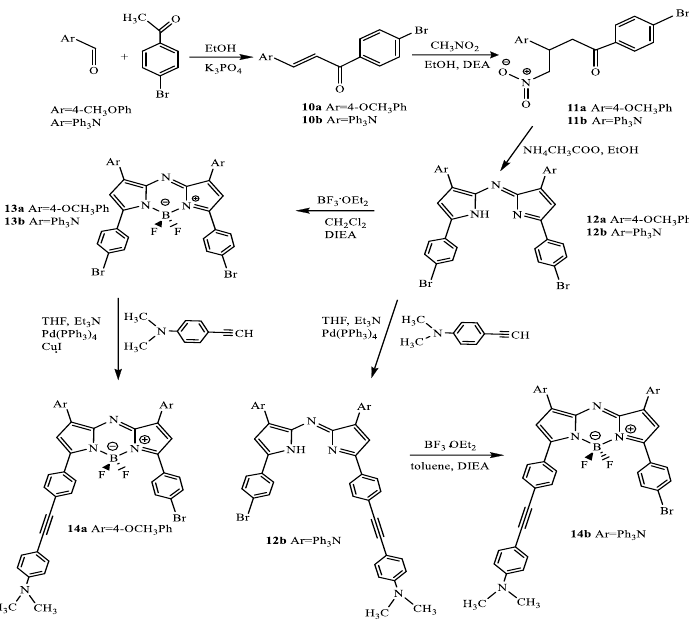
Scheme 4. Structures of investigated compounds.